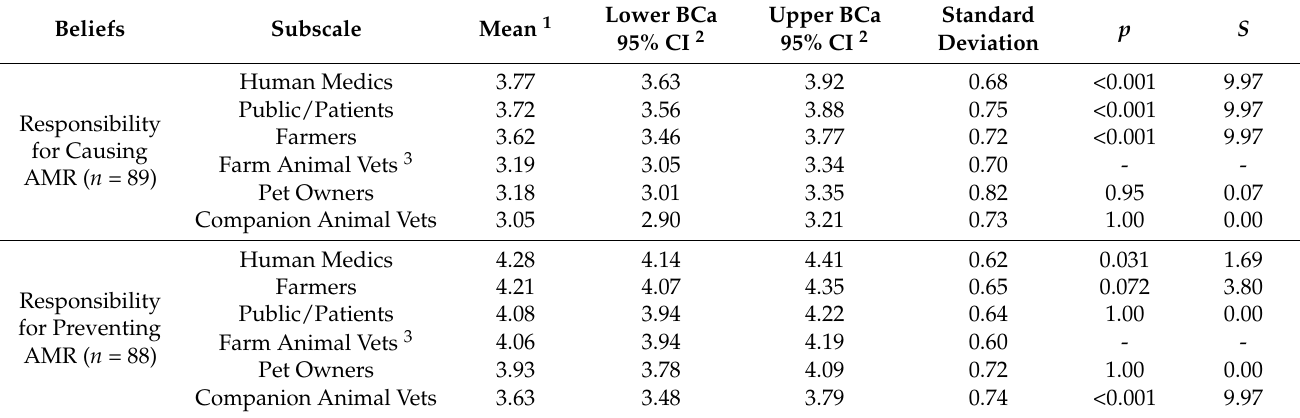
Table 3. Beliefs about Groups’ Responsibility for Causing or Preventing